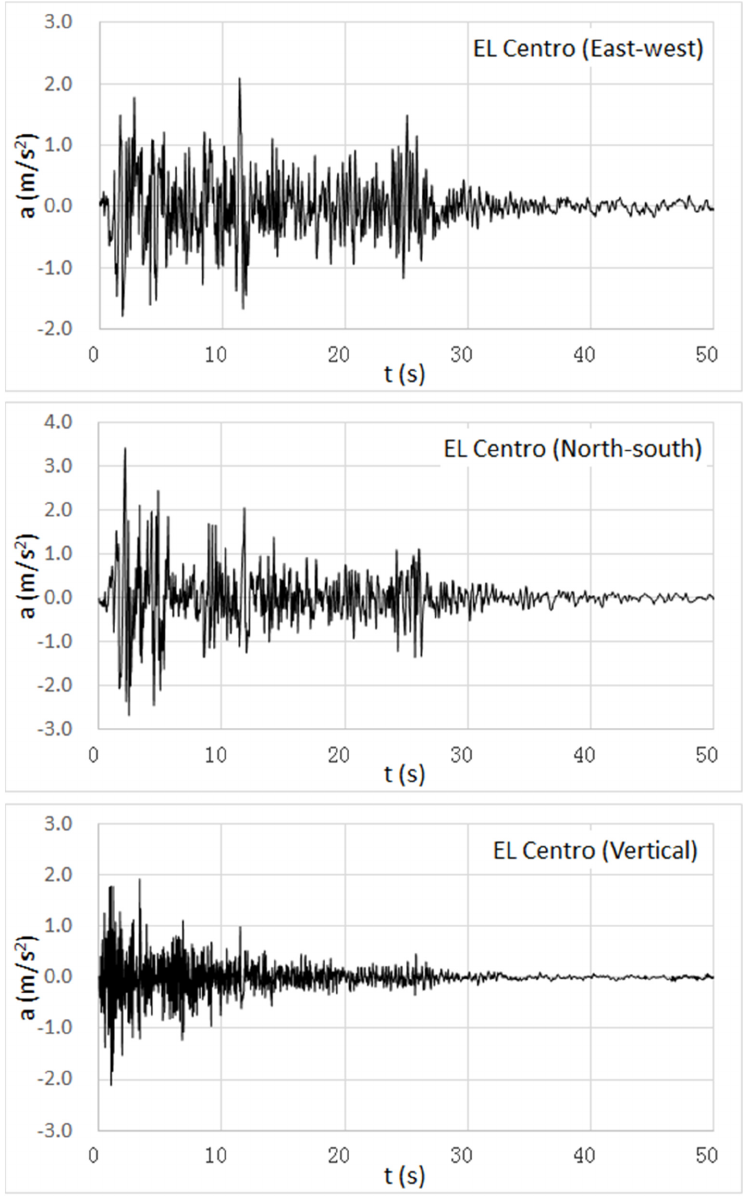
Figure 12. Time series of the seismic acceleration of the 1940 El Centro earthquake. (Upper: east − west component, middle: north − south component, lower: vertical component). In the cases of Wenchuan EW, El Centro EW, and El Centro NS, the excitation consists of only a horizontal component, while in the three other cases (El Centro vertical, El Cen- tro EW + vertical, El Centro NS + vertical), the excitation consists of a vertical component. For the horizontal vibration cases, as shown in Figure 13, the pressure oscillations at the